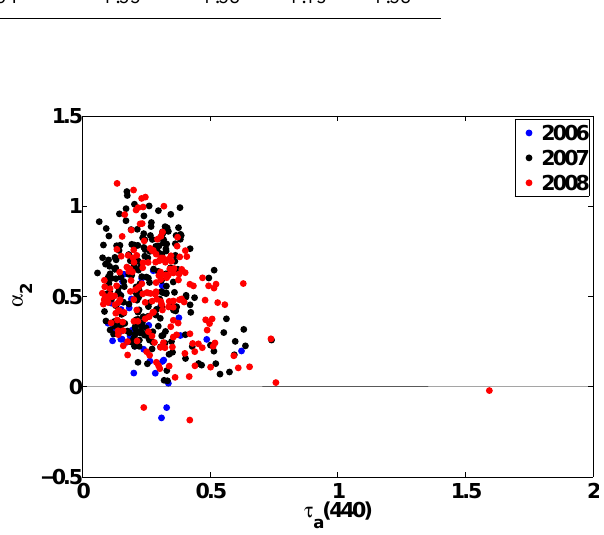
Fig. 4. Temporal evolution of daily averaged CWV (936nm) and temperature in Zanjan, October 2006 to September 2008, the IASBS site.